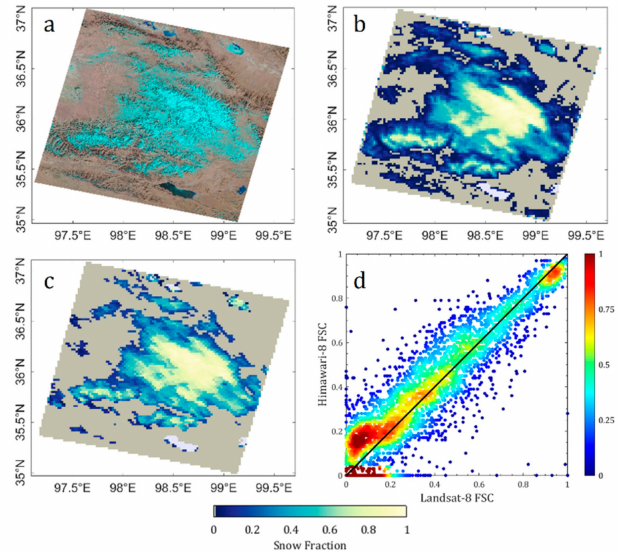
Figure 8. A case evaluation of Himawari–8 AHI fractional snow cover with Landsat–8 data for a rugged and sparsely vegetated area: ( a ) the Landsat–8 OLI image at WRS-2 134 / 035 on 26 January 2016; ( b ) the corresponding Landsat–8 fractional snow cover; ( c ) the corresponding Himawari–8 AHI fractional snow cover at UTC 4:00 a.m.; ( d ) the scatter plot displaying 8999 points of Himawari–8 AHI fractional snow cover versus Landsat–8 fractional snow cover at a 0.02 ◦ resolution.